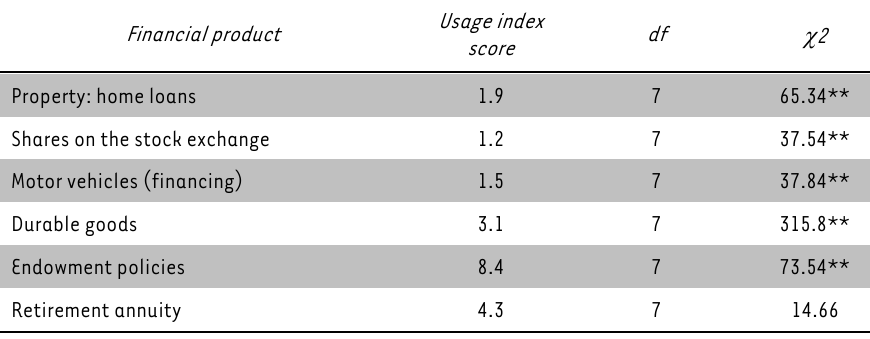
TABLE 6: Wealth management